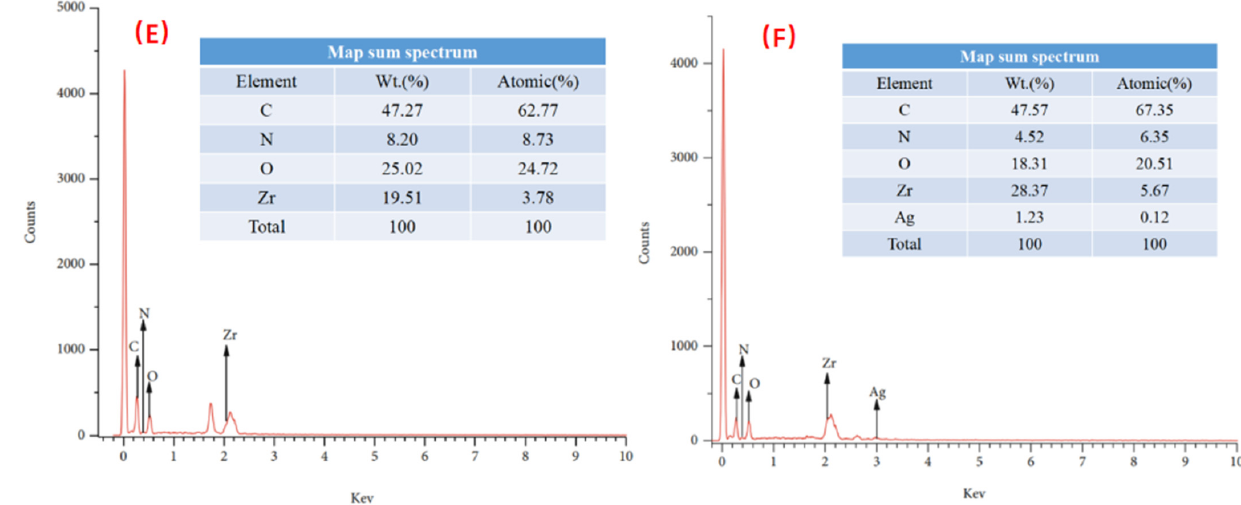
Figure 2. ( A , C ) Field emission scanning electron microscope (FE − SEM) and transmission electron microscopy (TEM) images of UiO − 66 − NH 2 ; ( B , D ) SEM and TEM images of Ag/UiO − 66 − NH 2 ; ( E , F ) Element mapping (EDS) of UiO − 66 − NH 2 and Ag/UiO − 66 − NH 2.